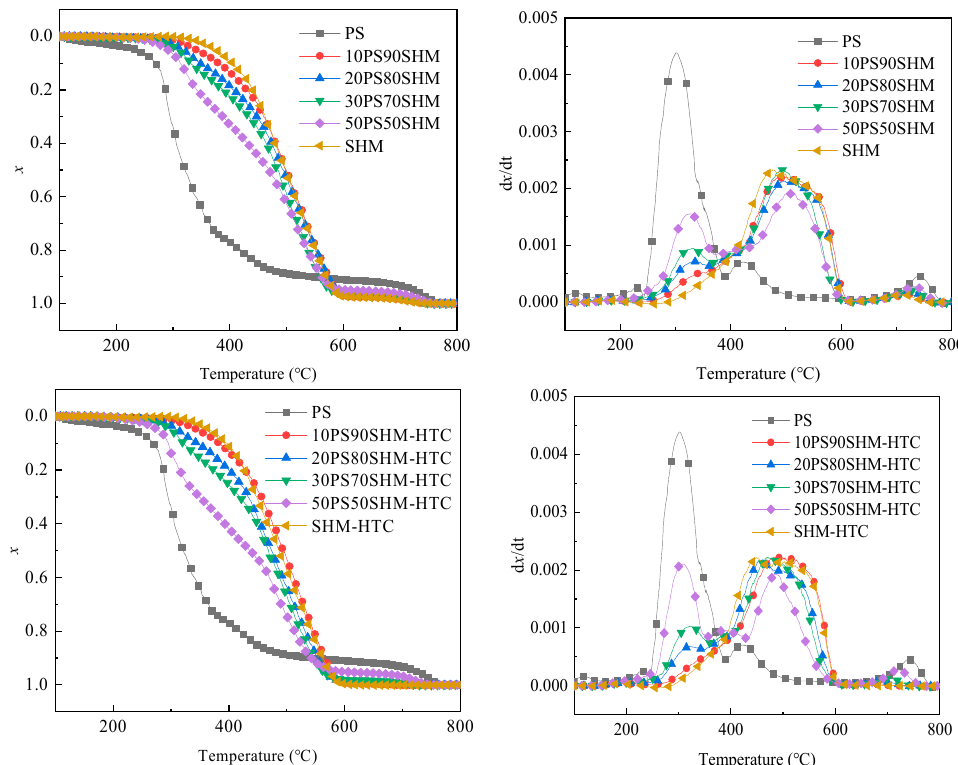
Figure 5. Co-combustion profiles of